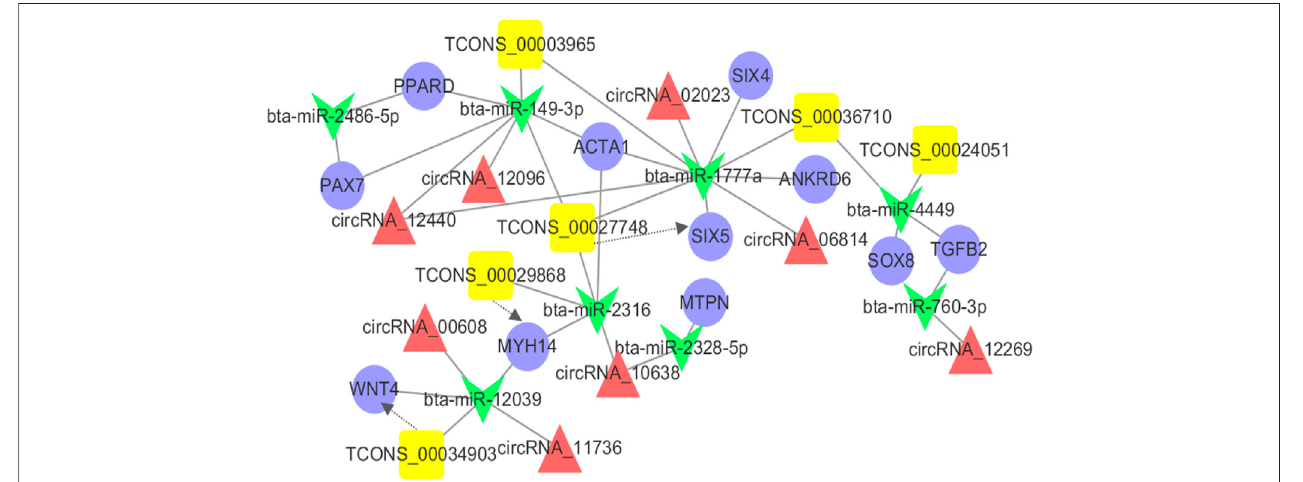
FIGURE5| TheceRNAco-regulationnetwork.Thebluecircle,yellowbox,redtriangleandgreenV-typerepresentedthedifferentiallyexpressedmRNAs,lncRNAs, circRNAs, and miRNA, respectively. The solid line indicated the co-regulation between miRNAs and other transcripts. The dotted line indicated the co-regulation between the lncRNAs and mRNAs.